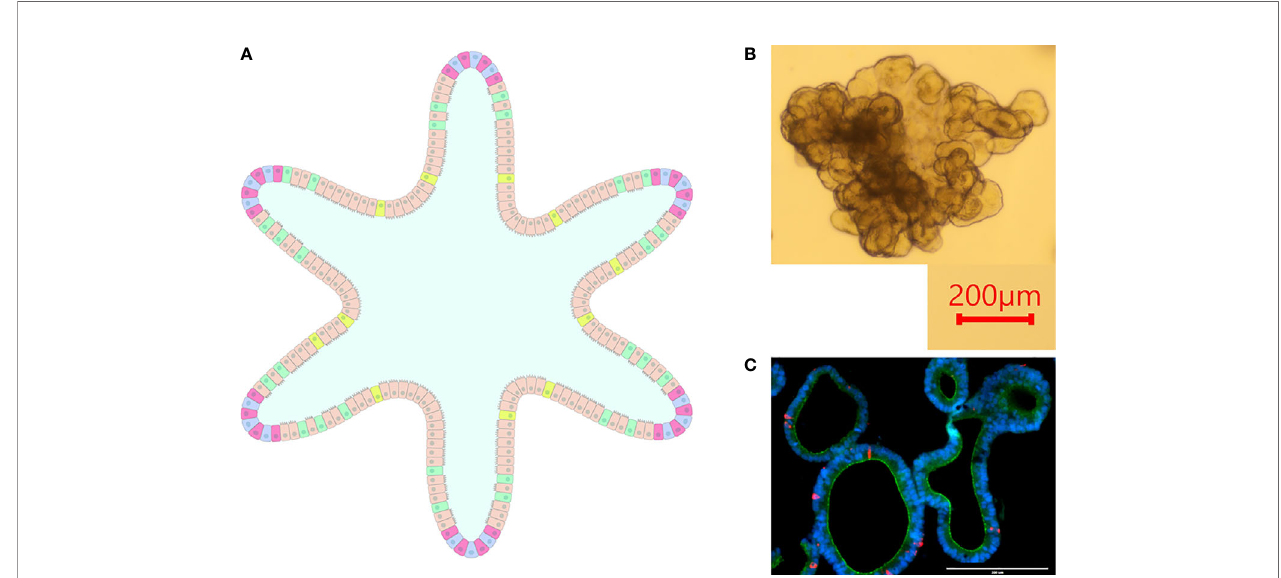
FIGURE 2 | Intestinal Organoids. (A) graphical representation of an intestinal organoid. The inside of the organoid corresponds to the luminal side, and the outside of the organoid corresponds to the basolateral side. Blue: intestinal stem cells, Red: Paneth cells, Tan: enterocytes, Green: goblet cells, Yellow: enteroendocrine cells. (B) Bovine intestinal organoid 6 days post-plating. Numerous folds and budding structures are noted, indicating crypt and villi-like domains. (C) Sectioned ovine intestinal organoid illustrating nuclei (DAPI), apical junctional protein ZO-1 (green), and chromogranin-A (red) indicating enteroendocrine cell